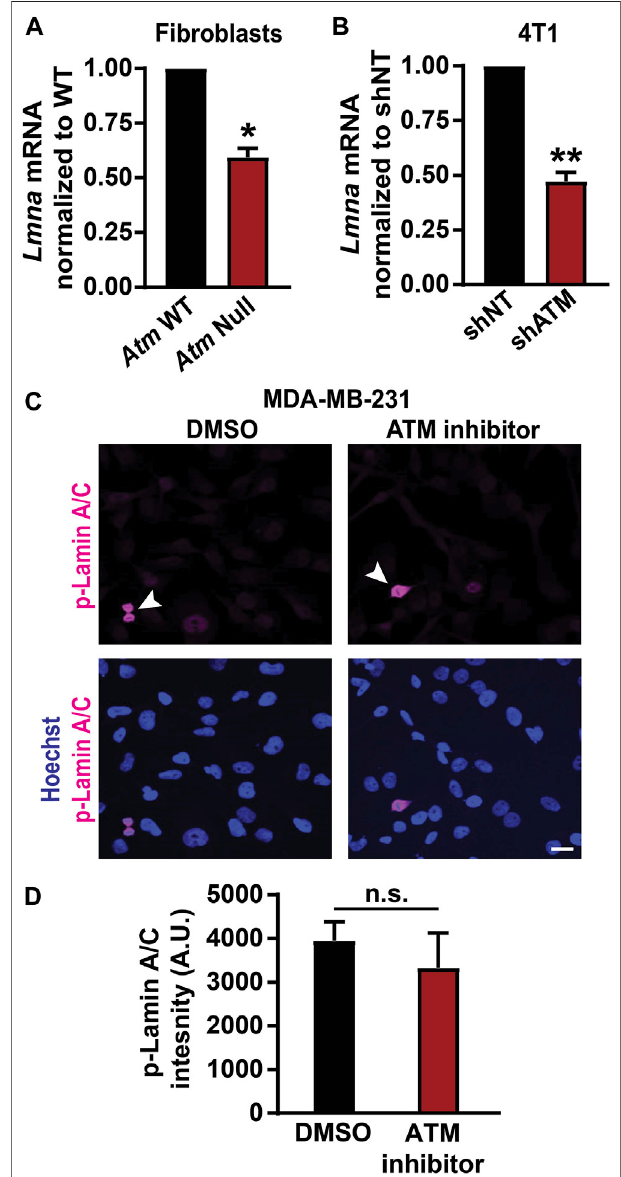
FIGURE 3 | Loss of ATM results in decreased lamin A/C transcription. (A) LMNA gene transcription levels in Atm wild-type (WT) and Atm -Null MEFs quanti fi ed by Real-time PCR, based on three independent experiments. Results were normalized to Atm WT cells. *, p < 0.05 based on unpaired t -testwithWelch ’ scorrection. N =3. (B) Lmna genetranscriptionlevelsin4T1 cells with inducible depletion of Atm by shRNA (shATM) and non-target controls (shNT). Results were normalized to shNT cells. **, p < 0.01 based on unpaired t -test with Welch ’ scorrection. N = 3 (C) Representative image panel of immuno fl uorescence labeling for phospho-lamin A/C (Ser22) in MDA-MB- 231 cells treated with 0.1% DMSO or 10 µM ATM inhibitor KU-55933. Mitotic cells (arrowhead) within the cell population serve as positive controls. Scale bar: 20 µm. (D) Corresponding quanti fi cation of phospho-lamin A/C total immuno fl uorescence intensity, based on the average values from three independent experiments. N = 3; unpaired t -test with Welch ’ s correction. Error bars in this fi gure represent mean ± s. e.m. of the mean values of each experiment.